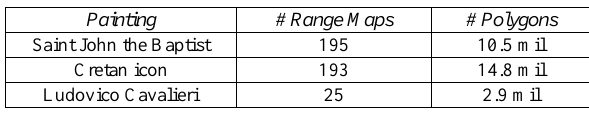
Table 3. Range-based surveying data and modelling